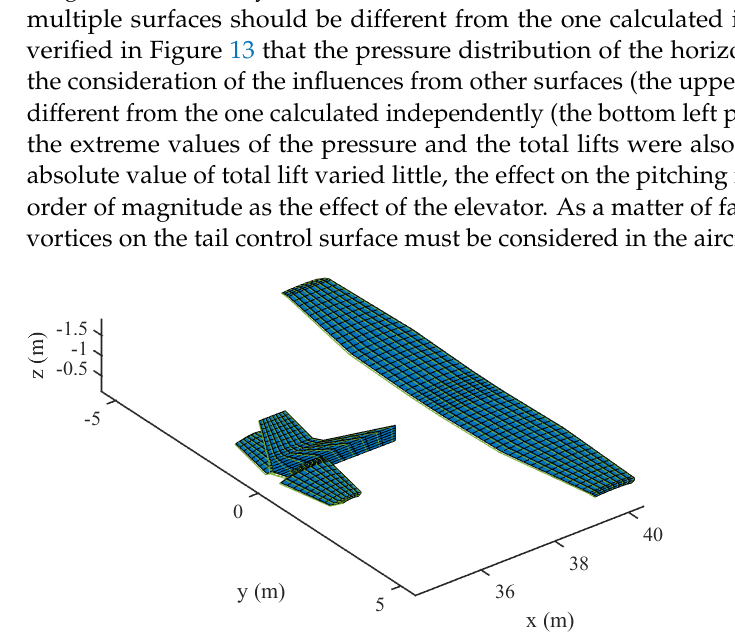
Figure 12. Modeling of a fixed-wing aircraft with multi-lifting surfaces.